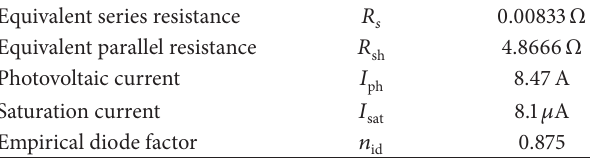
Table 2: Simulation parameters for SG-2300.